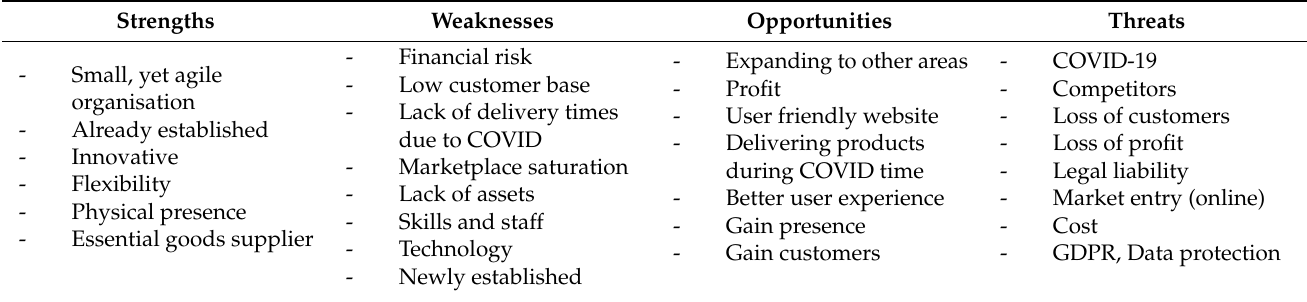
Table 1. SWOT Analysis of the prototype